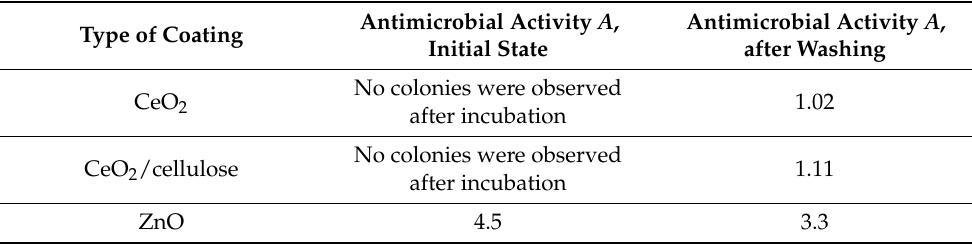
Table 1. Antibacterial properties of cotton fabrics with nanoscale particle